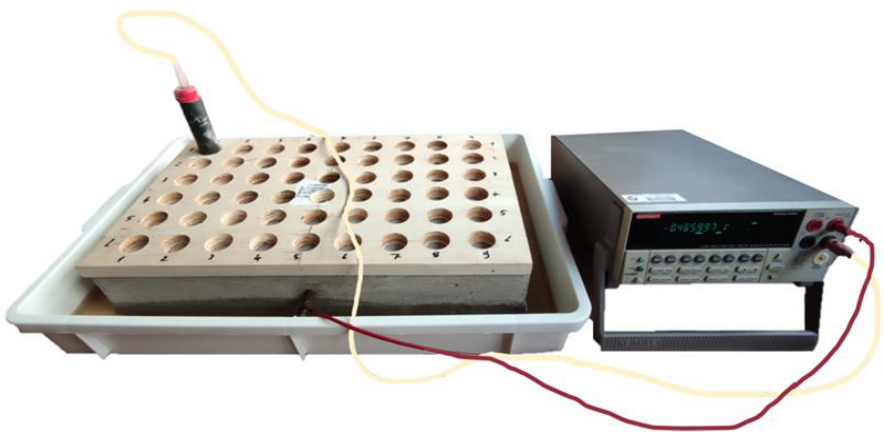
Figure 5. Acquisitions of Self-Potential (SP) on the reinforced concrete sample